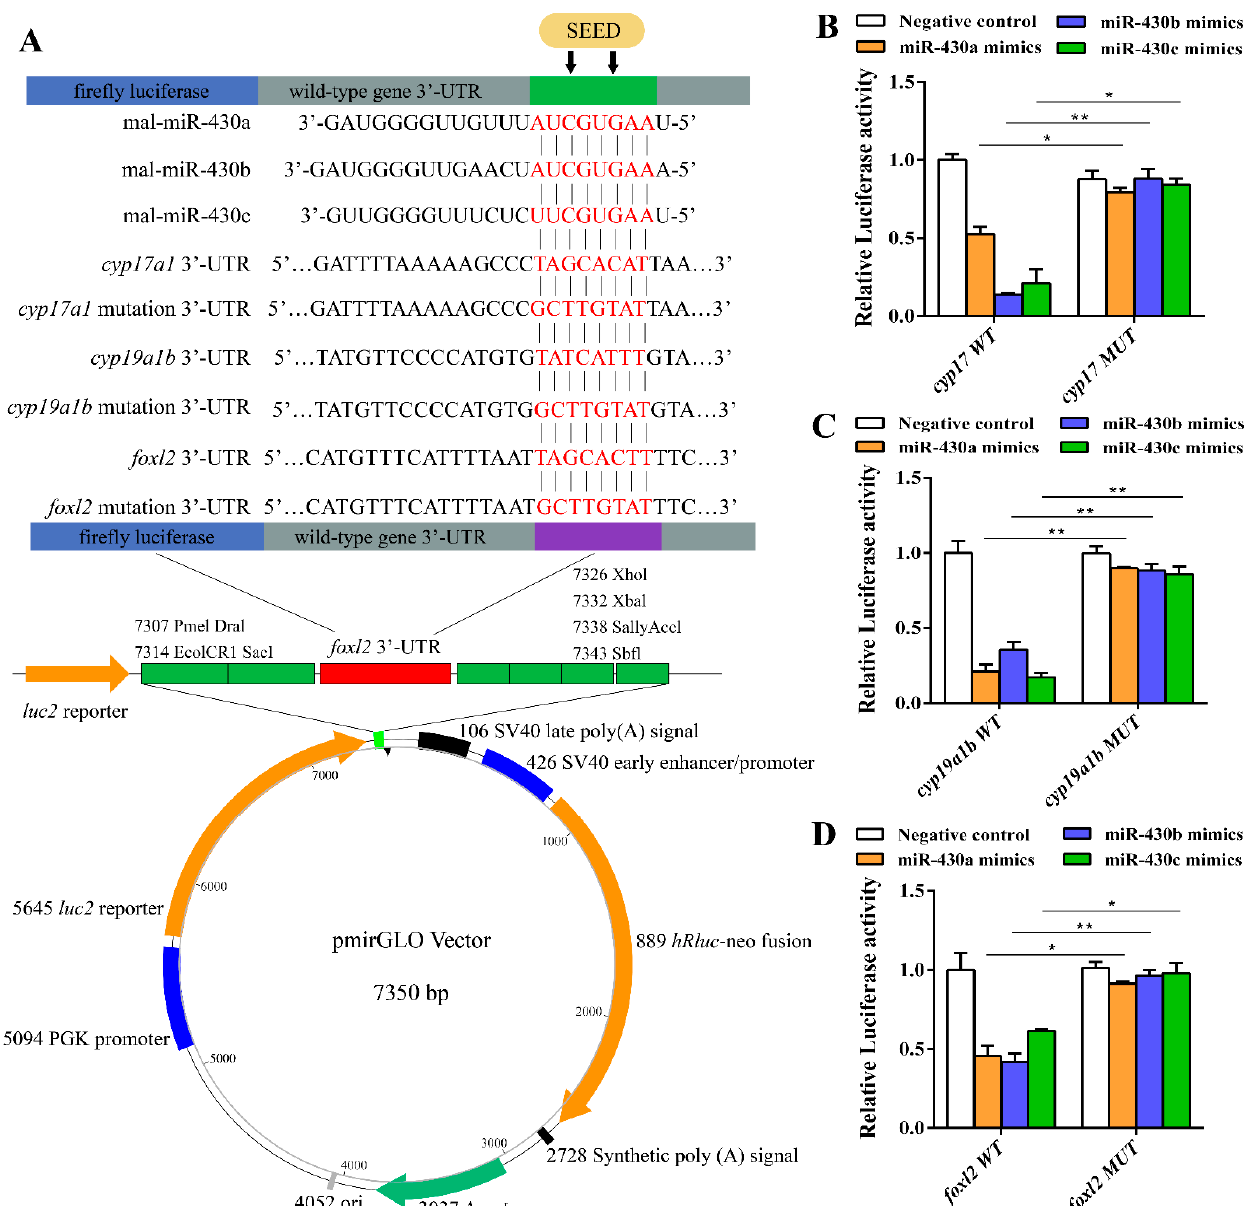
Figure 5. Schematic representation of the miR ‐ 430 target sequence within the 3 ′ UTR of cyp17 , cyp19a1b , and foxl2 ( A ) and activities of the luciferase reporter gene linked to the 3 ′ UTR of cyp17 ( B ), cyp19a1b ( C ), and foxl2 ( D ). The pmirGLO luciferase reporter plasmids with the wild ‐ type or mutated 3 ′ UTR sequences of cyp17 , cyp19a1b , and foxl2 were transiently transfected into HEK ‐ 29T cells along with 20 μ M miR ‐ 430 mimics or negative control. Luciferase activities were measured after 24 h, and firefly luciferase was used for normalization. Values are means ± SEM., n = 3. * p < 0.05, ** p < 0.01. The experiment was repeated at least three times.